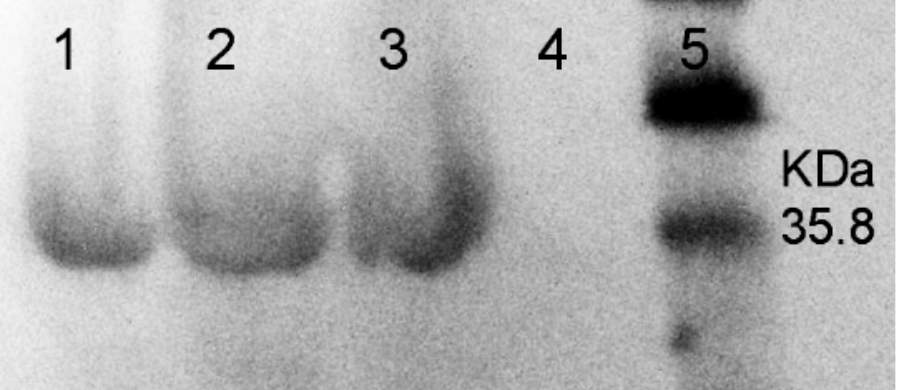
Figure 2: GH+GFP protein detection by Western blot from the different treatments showing positive reaction in larvae pool protein 48 h after fertilization: 1) 0.5 Kv, 2) 0.75 Kv, 3) 1.0 Kv and 4) negative control, 5) protein ladder